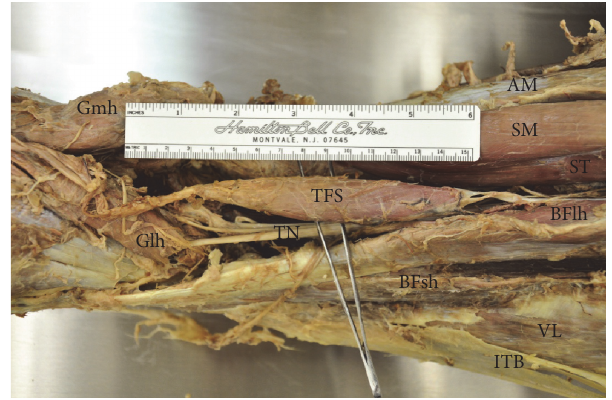
Figure 1: Dissection of right posterior thigh and popliteal fossa to show tensor fasciae suralis muscle (TFS: tensor fasciae suralis muscle; TN: tibial nerve; Gmh: gastrocnemius muscle, medial head;